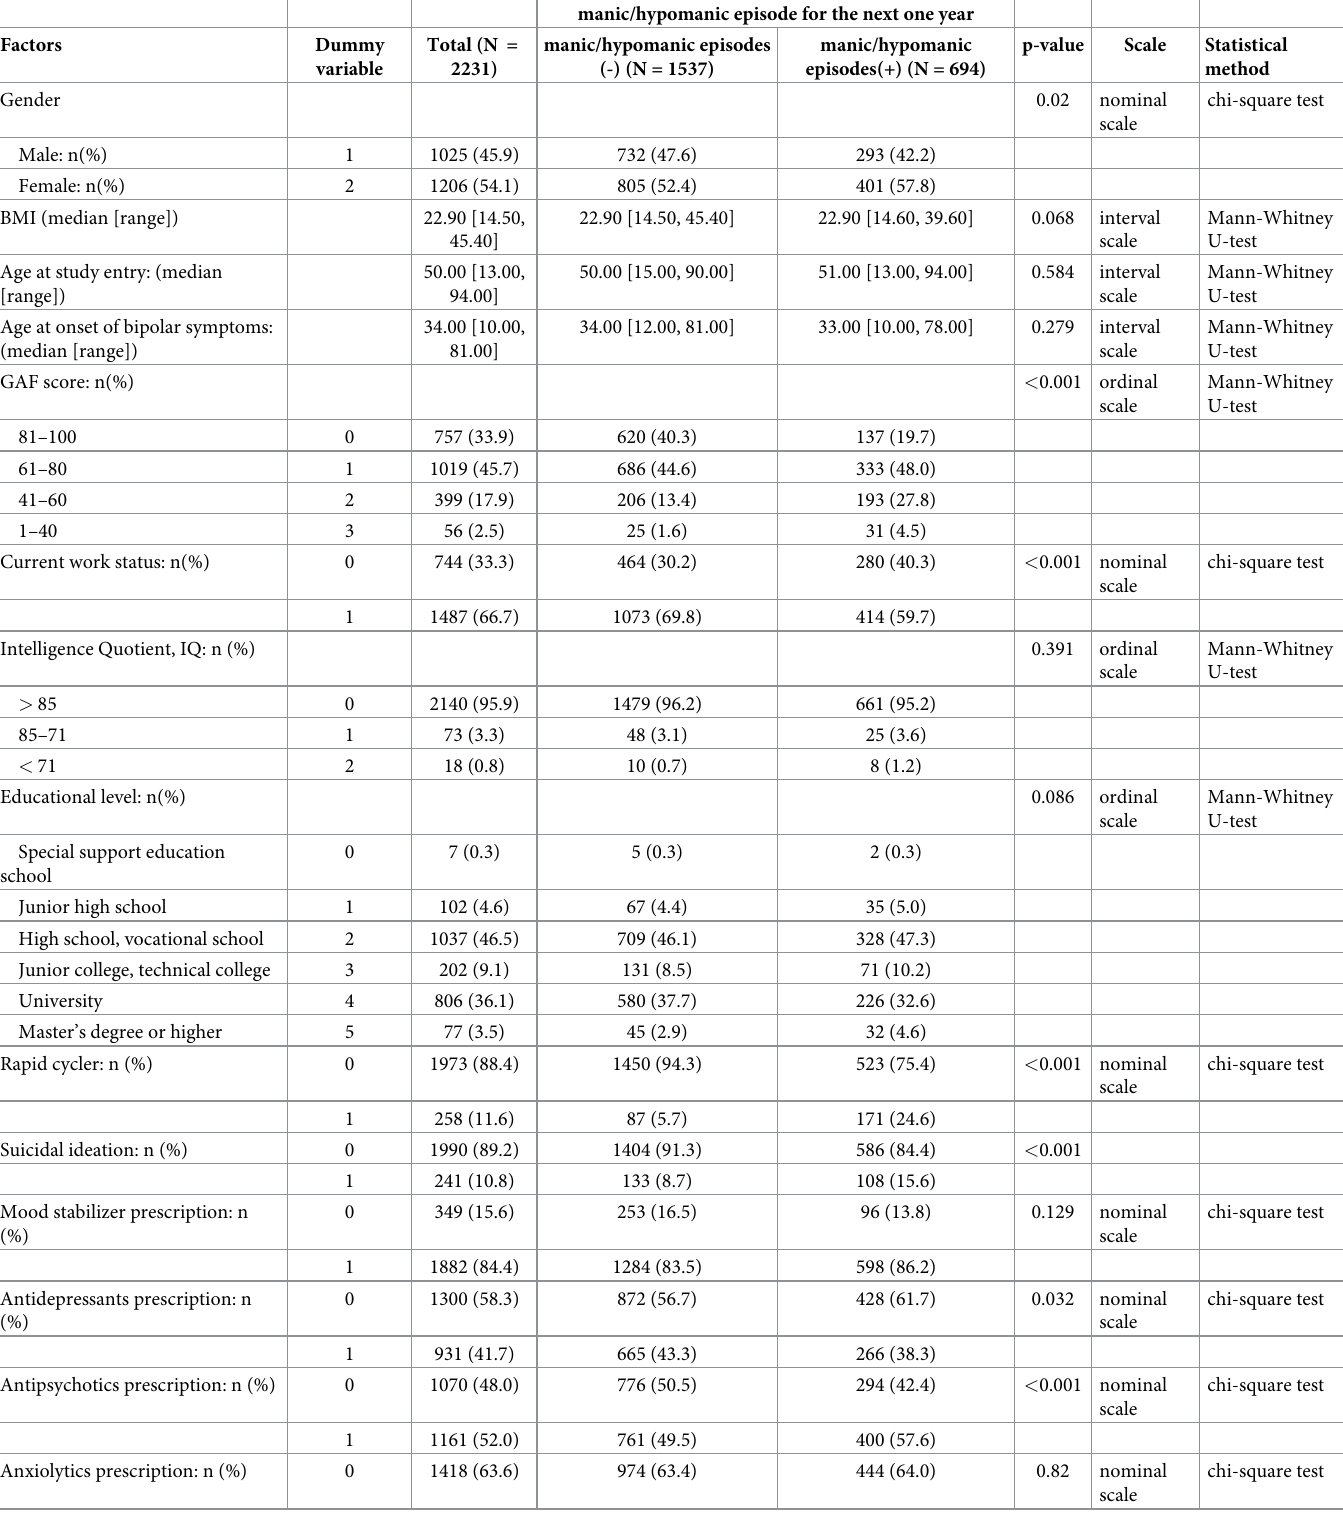
Table 1. Demographic and clinical data for